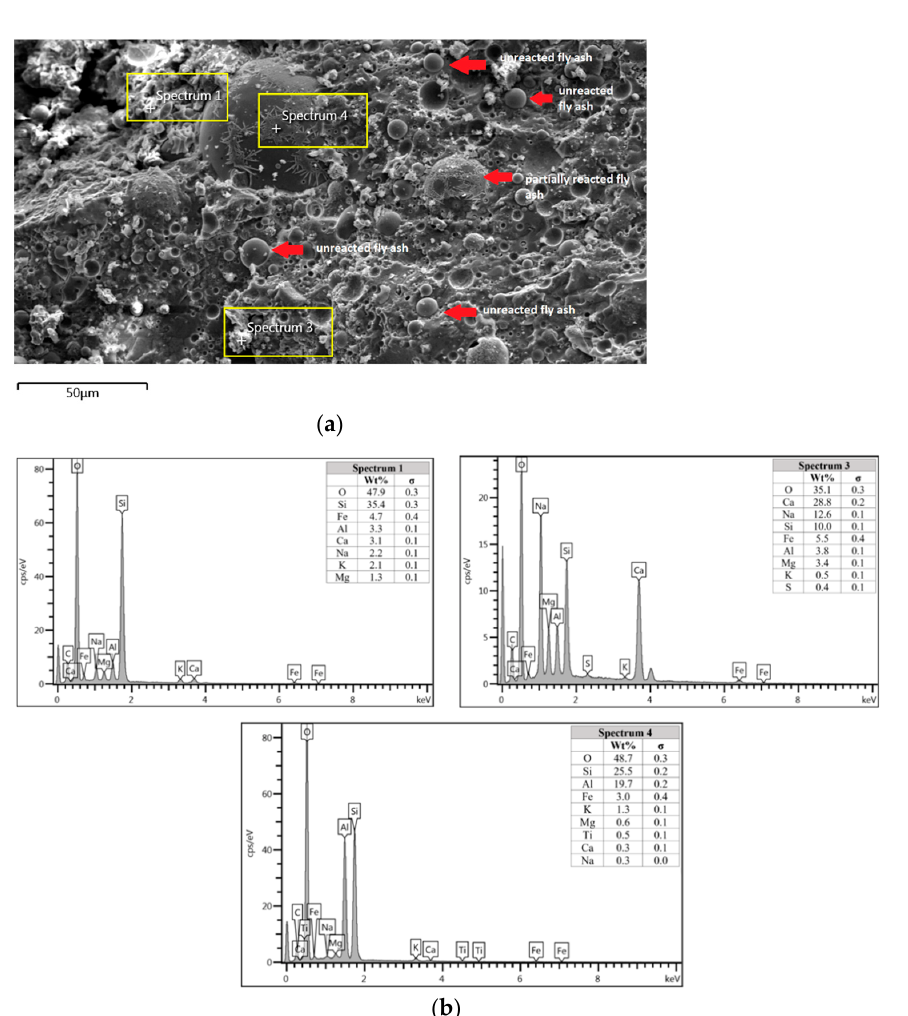
Figure 7. ( a ) Morphology of AAFA specimens cast in seawater. ( b ) EDS for AAFA specimens cast in seawater.